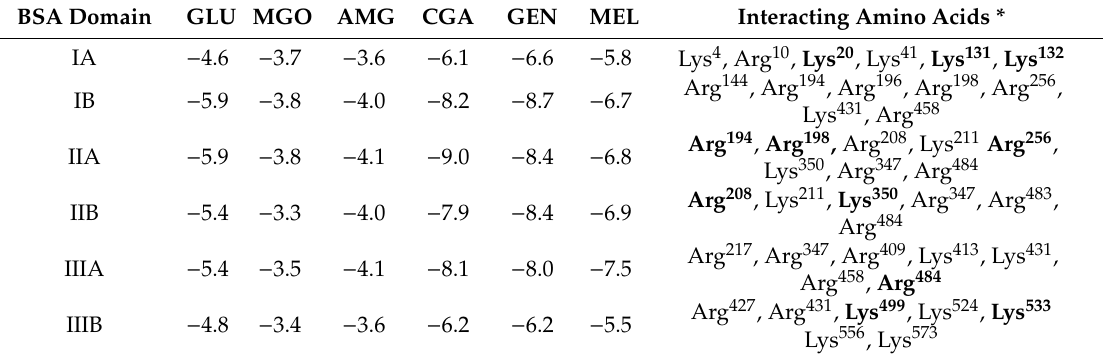
Table 3. Binding energies (kcal mol − 1 ) between BSA (six di ff erent domains) and the pro-glycation (glucose and MGO) and antiglycative (aminoguanidine, CGA, genistein, and melatonin) agents predicted using in silico molecular docking and the interacting arginine and lysine